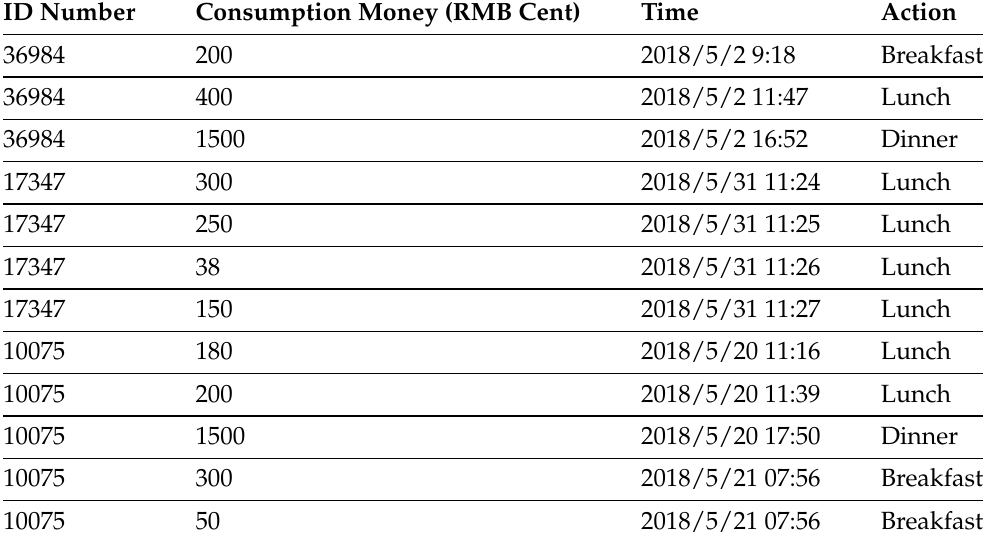
Table 1. Collected raw data.